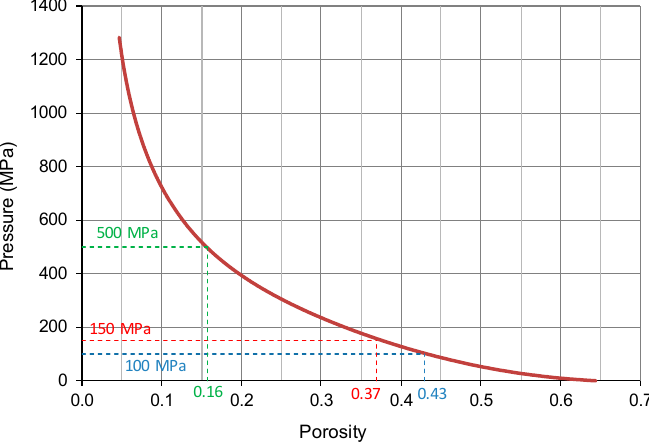
Figure 3. Compressibility curve of the Fe WPL200 powder.